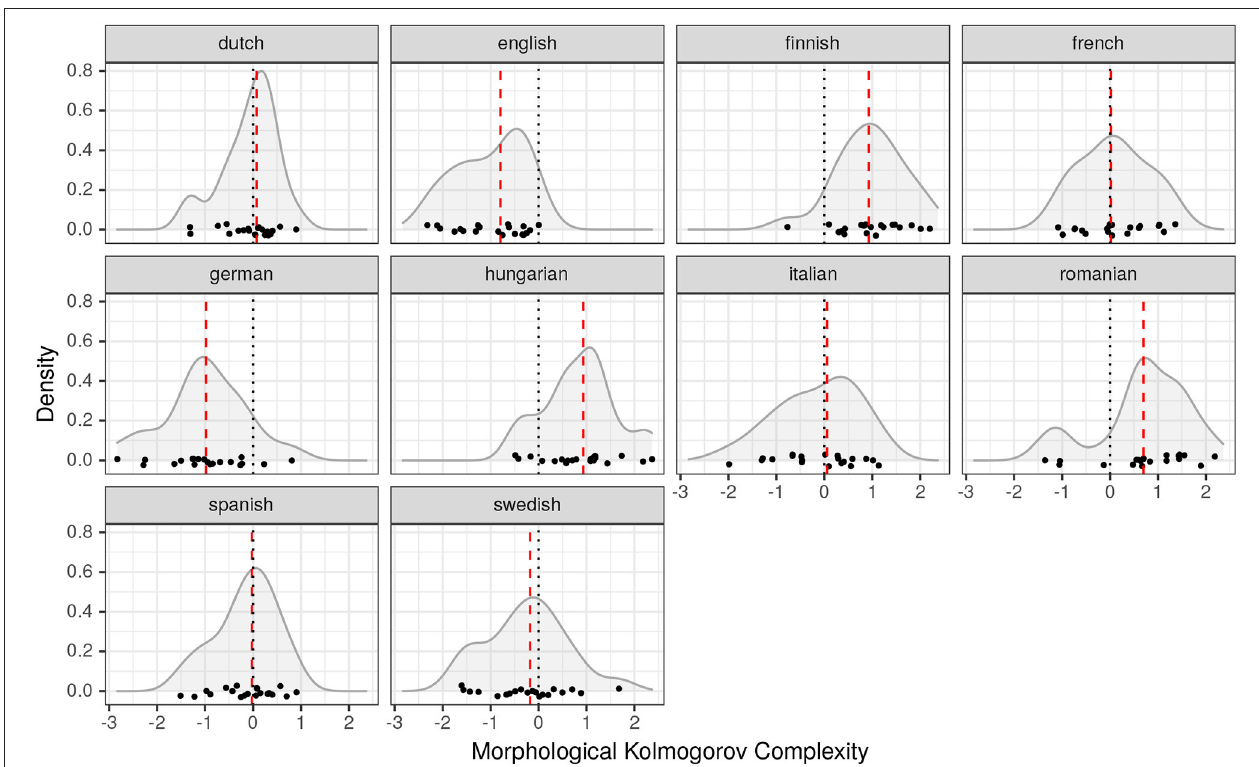
FIGURE 3 | Densities of Kolmogorov-based morphological complexity for 10 languages. Each dot corresponds to a measurement applied to one of 20 chunks of text. Red dashed lines indicate median values.